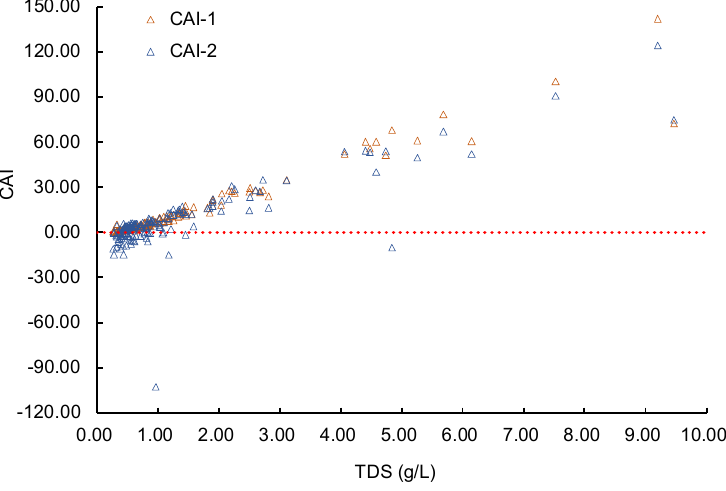
Figure 15. The chloro-alkaline indices of groundwater samples.